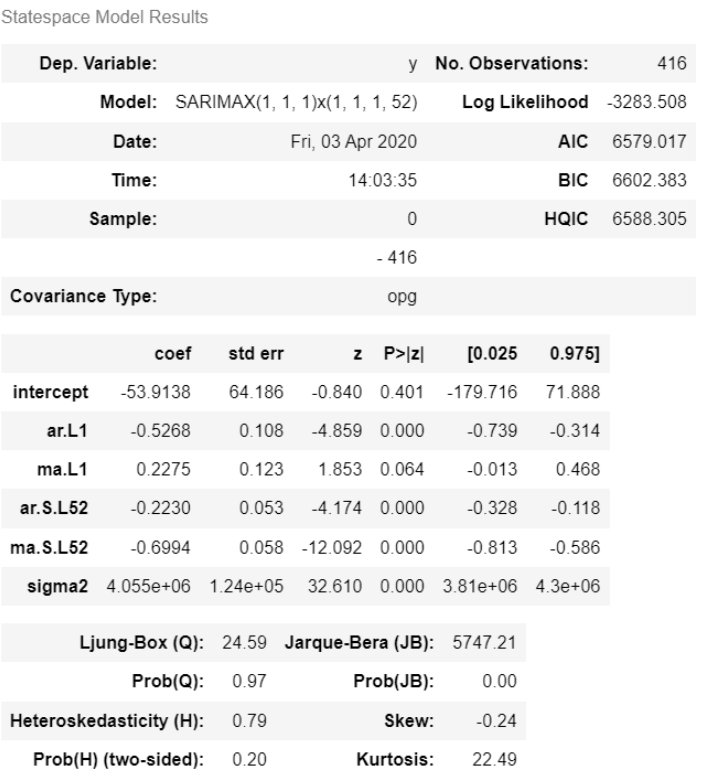
Figure 3. ARIMA model statespace.